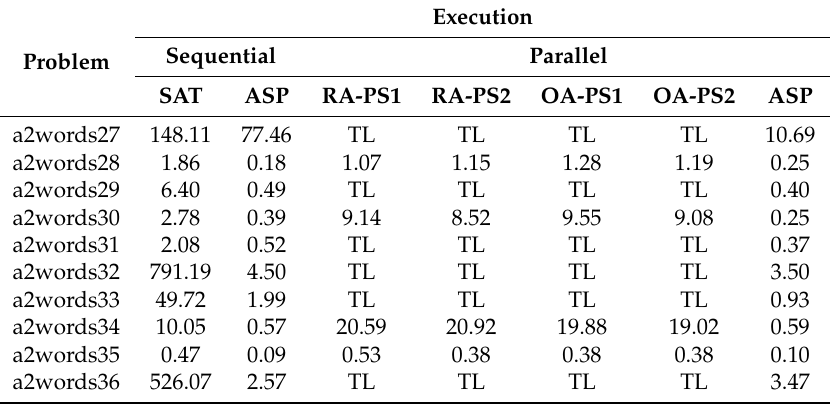
Table 2. Execution times of exact solving NFA identification in